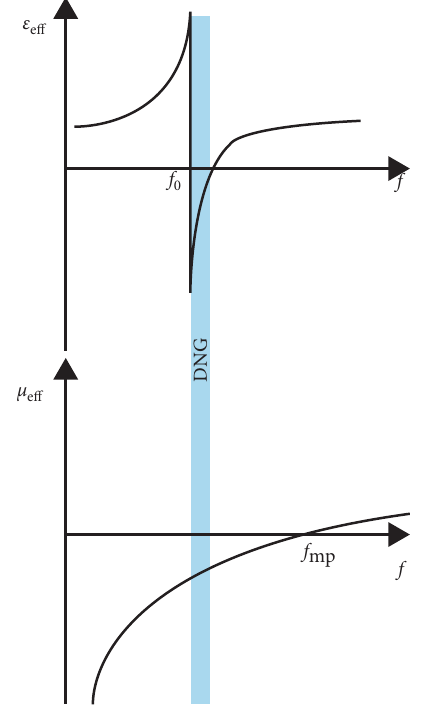
Figure 3: The ε series gap, respectively.